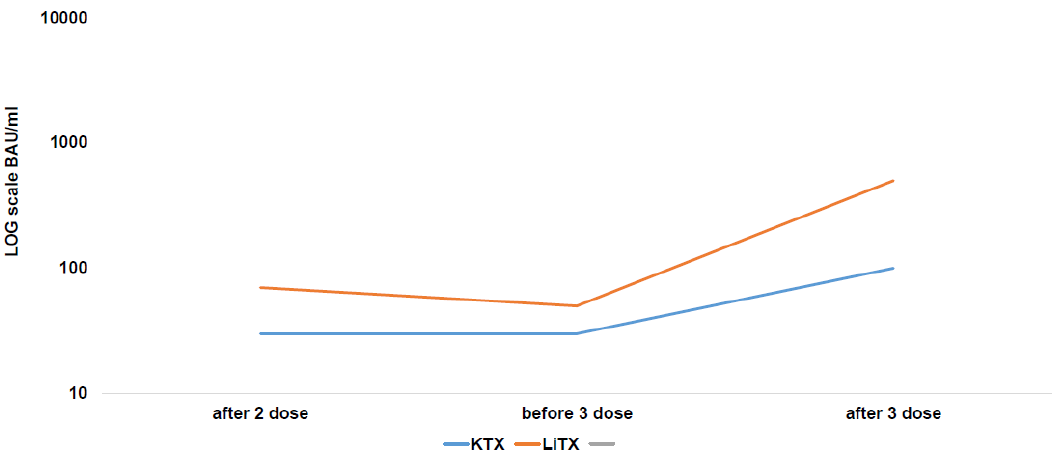
Figure 2. Anti-SARS-CoV-2 antibody titers according to the type of transplantation.